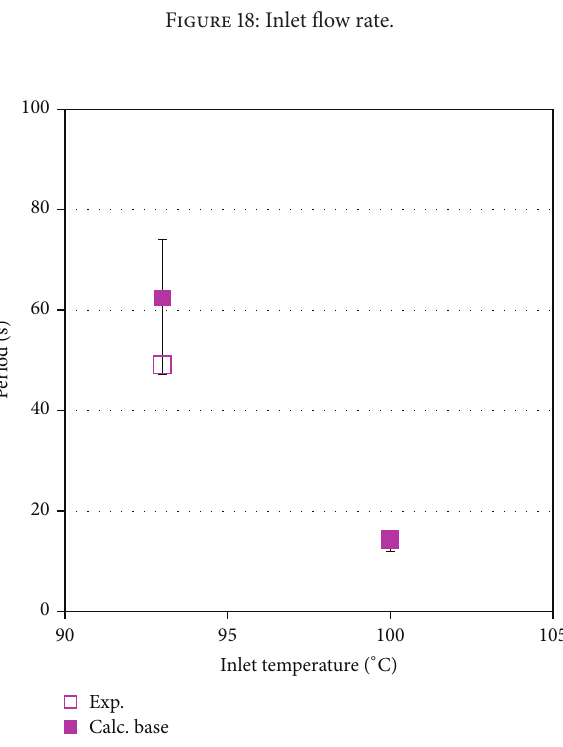
Figure 18: Inlet flow rate.